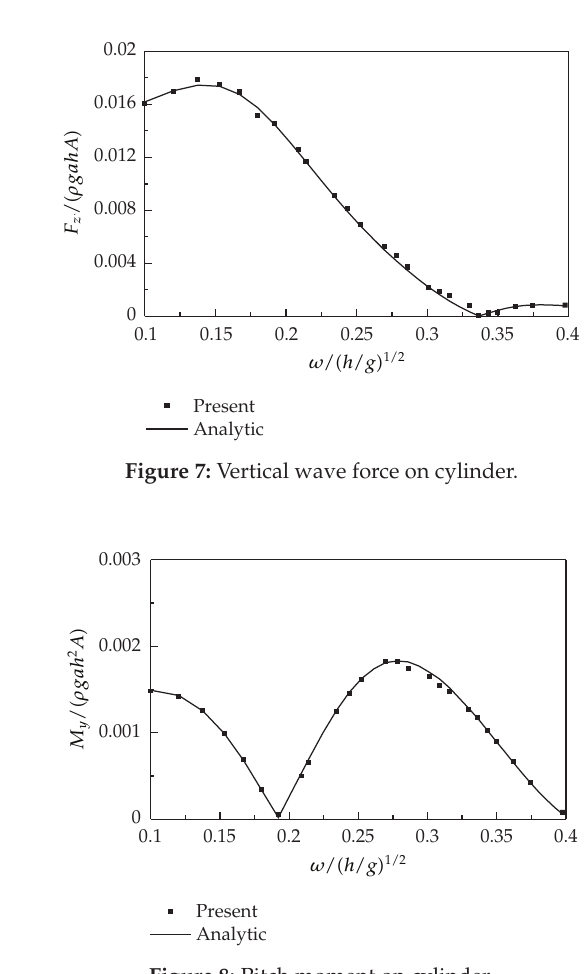
Figure 8: Pitch moment on